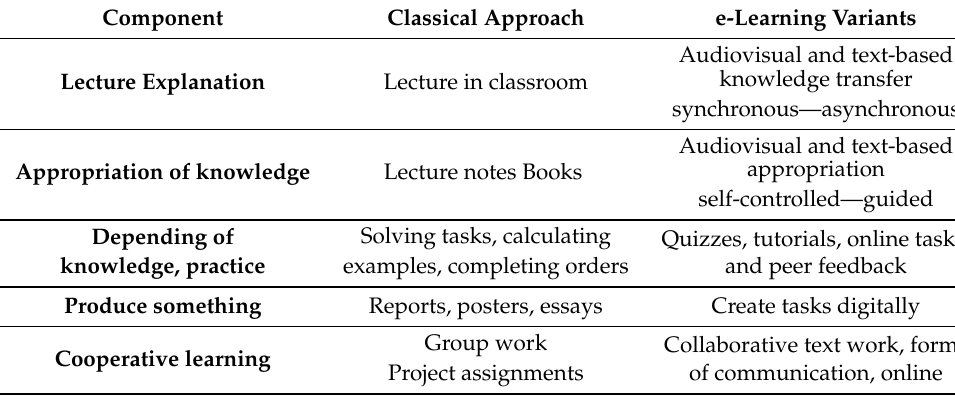
Table 2. Changes to be made from classical teaching to e-learning (after